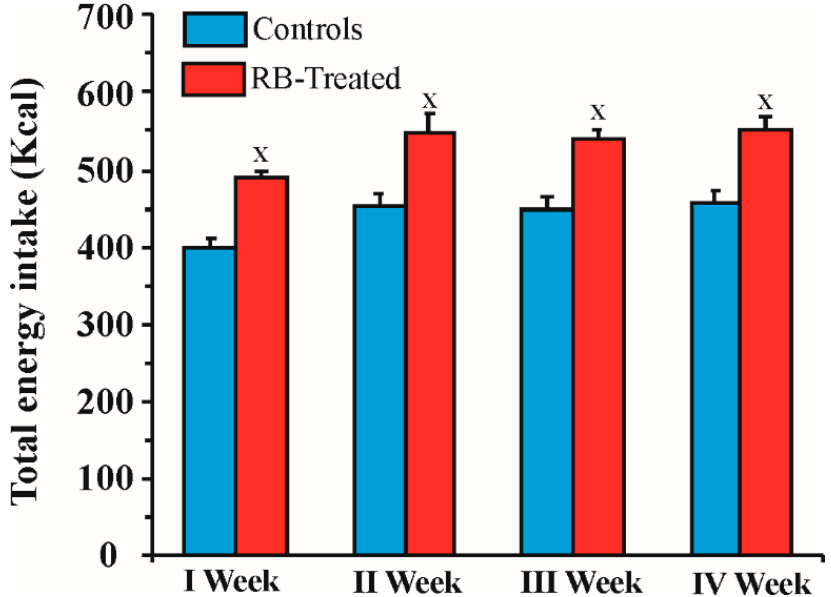
Figure 2. Total energy intake in control and RB-treated rats during the 4 weeks of treatment. Values are expressed as the mean ± SEM. x p < 0.001 RB-treated vs. controls. Statistical analysis: two-way ANOVA.